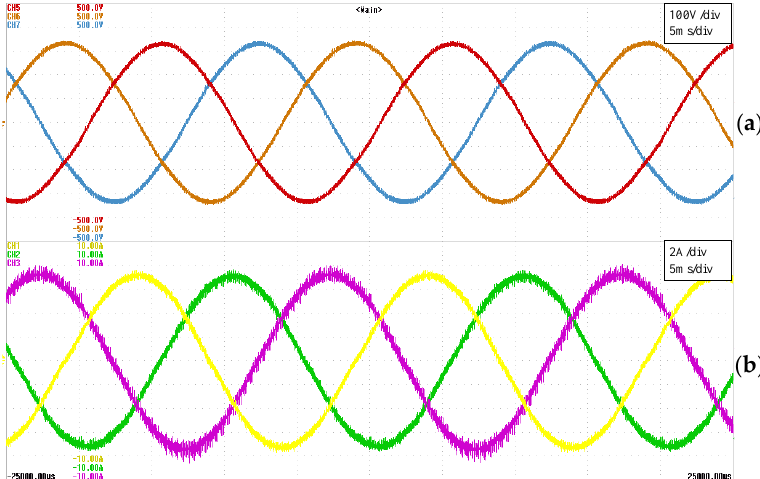
Figure 27. NLM operation with a 2 kW load. ( a ) line-to-line output voltages and ( b ) output currents.